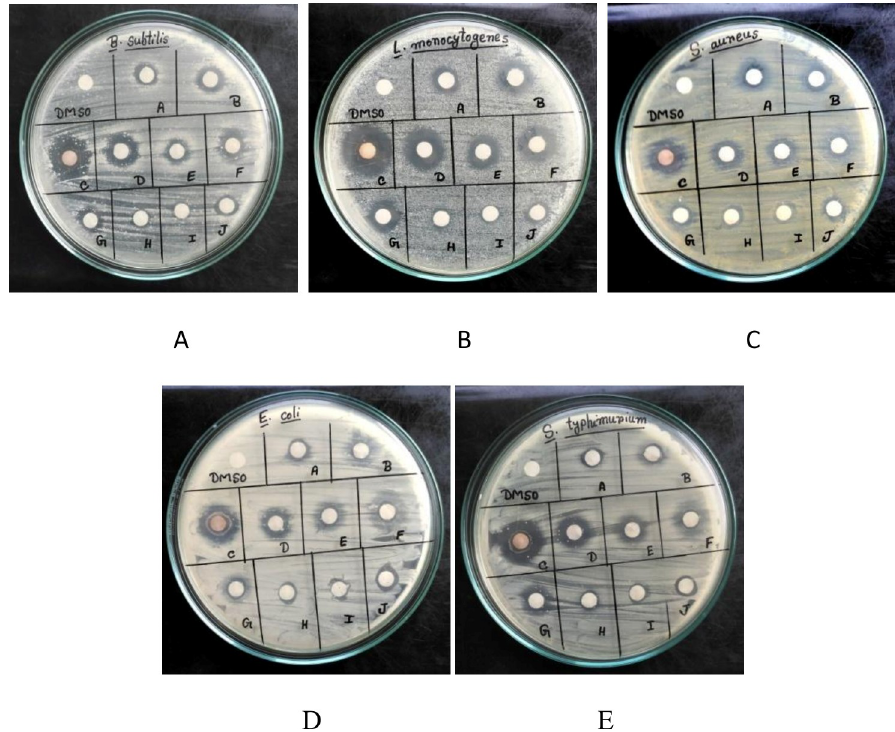
Fig 8. Zones of inhibition produced by compounds derived from TLC plate, against pathogenic bacteria A- B . subtilis; B- L . monocytogenes ; C- S . aureus ; D- E . coli ; E- S . typhimurium . https://doi.org/10.1371/journal.pone.0214744.g008 retention time (RT), chemical formula, and MW are represented in Tables 3 and 4. Their chemical structures are also represented in Figs 9 and 10. Among the 12 different compounds present in band C, based on peak area percentages d-Norandrostane (5 à ,14 à ) (steroid), Longi- folenaldehyde (terpene), 4,8,13-cyclotetradecatriene-1,3-diol,1,5,9-trimethyl-12-(1-methy- lethyl) (macrocyclic diterpene), 2,4,7,14-Tetramethyl-4-vinyl-tricyclo[5.4.3.0(1,8)]tetradecan-